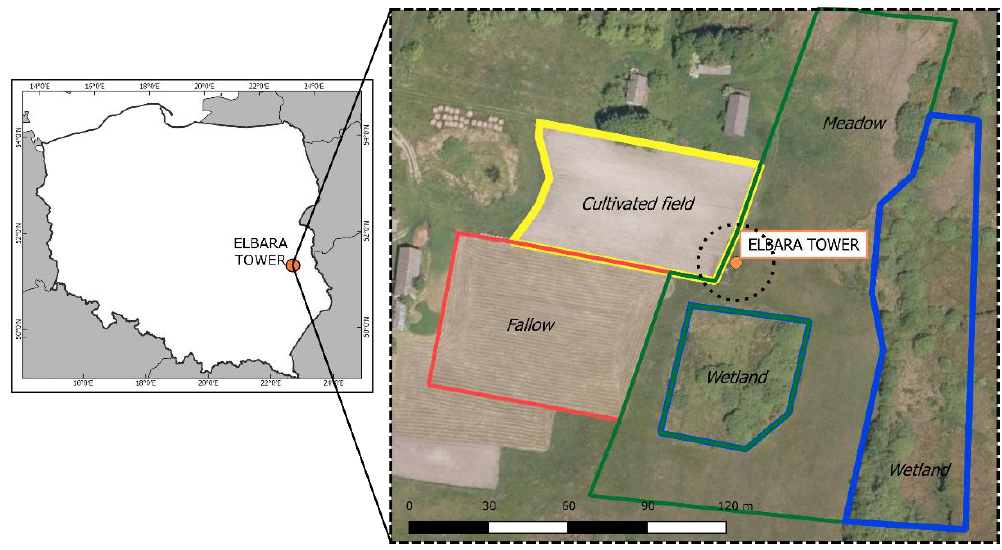
Figure 1. Location of the Bubnów test site. ESA L-band microwave radiometer (ELBARA) III is marked with a circle. The dotted circle indicates a range of the radiometric footprint for the elevation angle 66°.